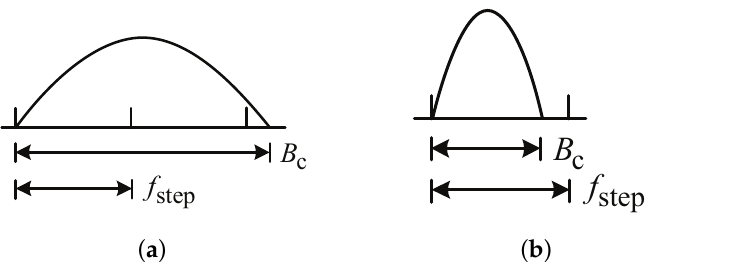
Figure 3. The relationship between frequency search step and correlation bandwidth: ( a ) f step ≤ B c /2; ( b ) f step > B c .